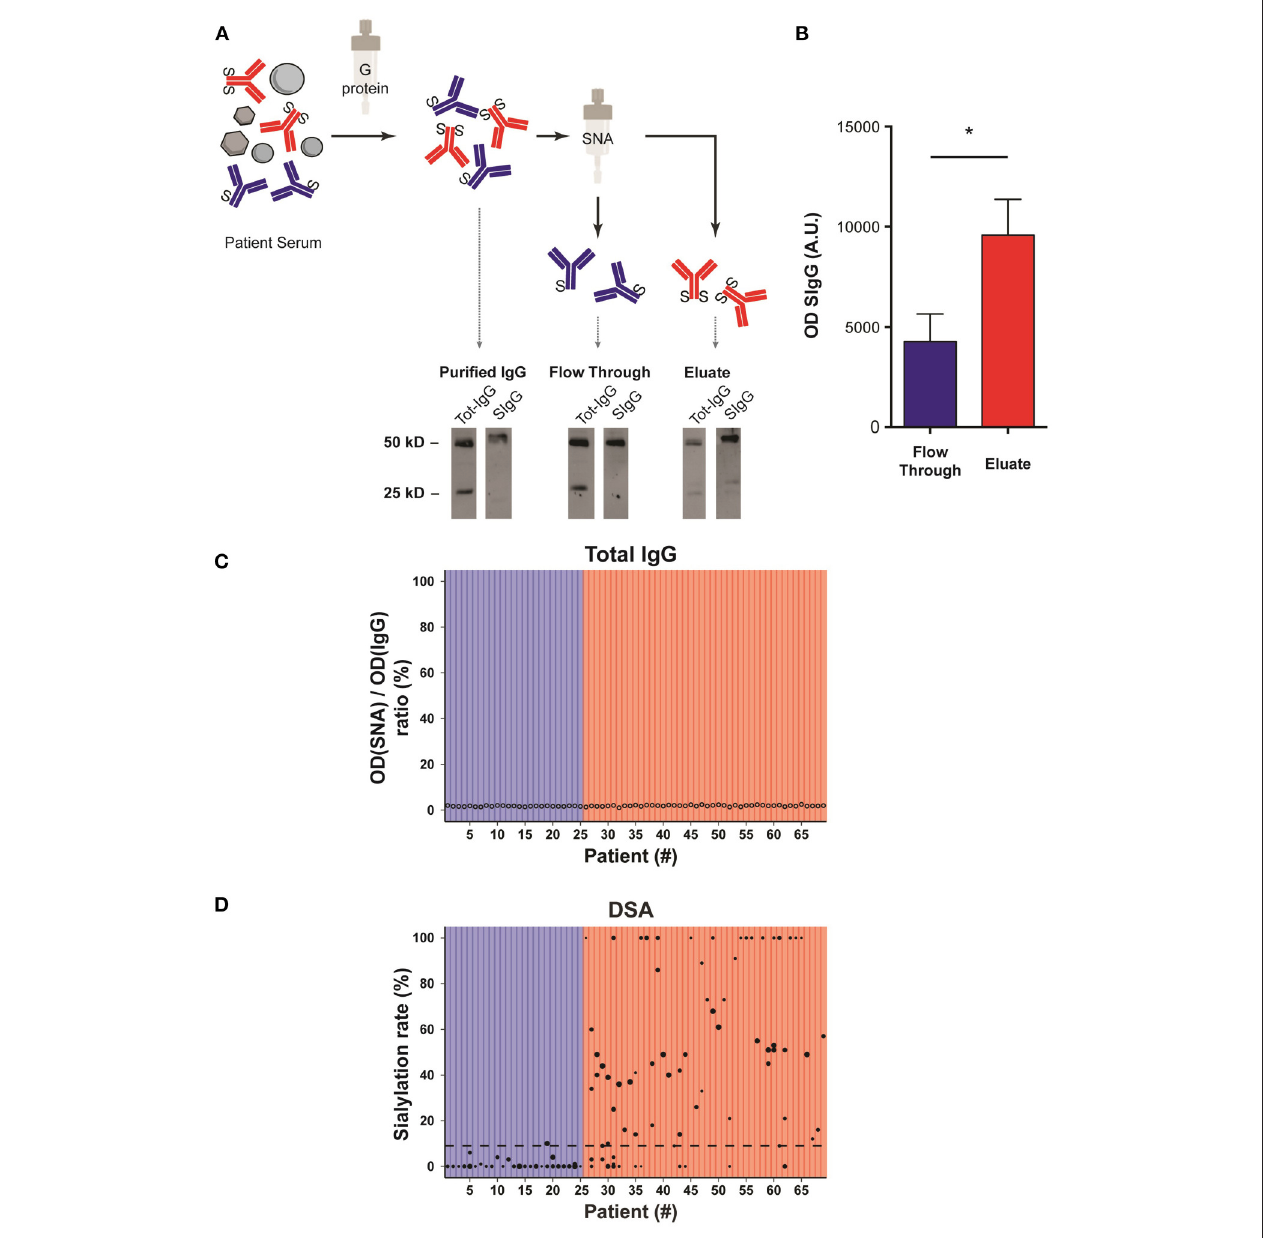
FIGURE 3 | Sialylation status of the Fc fragment of DSA is variable. (A) Schematic representation of the method used to determine the sialylation status of IgG Fc fragments. Sera banked at the time of the diagnosis of AMR were passed through a G protein column and purified IgG were then passed on Sambucus nigra lectin (SNA) column that binds to sialic acid. The un/monosialylated IgG (blue) containing flow through and eluate (enriched in the di-sialylated IgGs, red), were collected separately and analyzed by western blot. (B) Western blot of the flow through (un/monosialylated IgGs) and the eluate (di-sialylated IgGs) were revealed with SNA, and the intensity of the 50 kD band, which corresponds to the IgG heavy chain (Fc fragment), was measured. * p < 0.05; t -test. (C,D) Approximation of the total IgGs di-sialylated proportion ( C , open circles,) and measurement of the di-sialylated DSA proportion ( D , black circles), determined at the time of AMR diagnosis, are plotted for each patient ( n = 69). (D) Each symbol is a distinct DSA specificity, the MFI of which is proportional to the size of the circle. The 69 transplanted patients are distributed into two groups depending on whether the pondered proportion of di-sialylated DSA was below (low DSA sialylation, n = 25; blue) or above (high DSA sialylation, n = 44; red) the median of di-sialylated DSA (9%, dashed line).